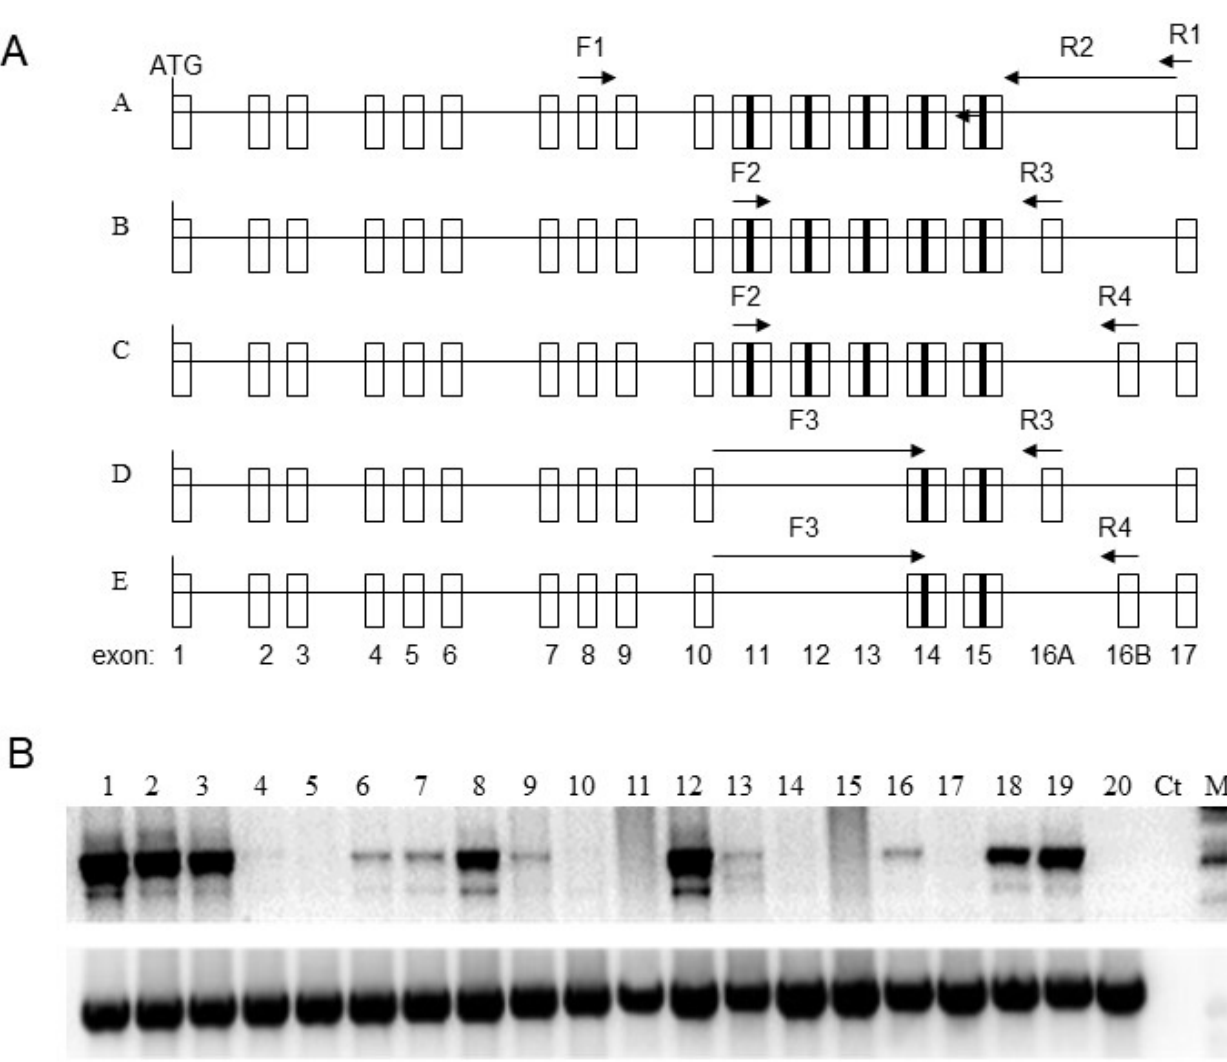
Figure 1. Expression of GluR6 isoforms in cell lines. ( A ) Positions of primers used for amplifying GluR6 alternative transcripts (A – E). The numbered open rectangles represent exons 1 – 17, and solid rectangle indicates the transmembrane domain. F1-R1 primers are common to all isoforms. F1-R2, F2-R3, F2-R4, F3-R3, and F3-R4 amplify GluR6 isoforms A, B, C, D, and E, respectively. ( B ) RNA responding to GluR6 was amplified with primers F1-R1 that are common to all isoforms. The bottom row shows relative levels of GAPDH transcript. Lane1: HDFs; lanes 2 and 3: WM239A and WM266A (melanoma); lane 4: A549 (lung); Lane 5: DU145 (prostate); lane 6: SUSM1 (chemically immortal-